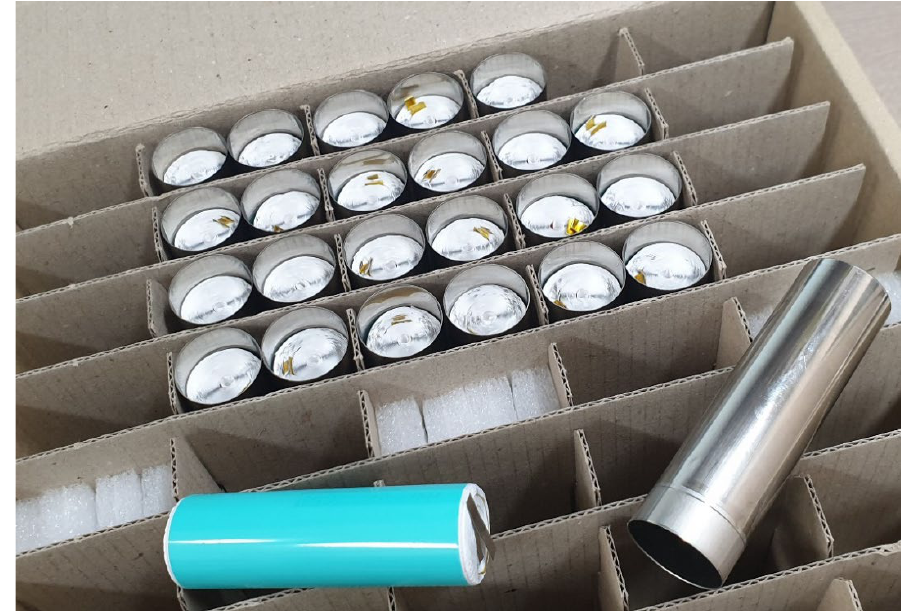
Figure 2. Photograph of lithium-ion batteries used in this study.